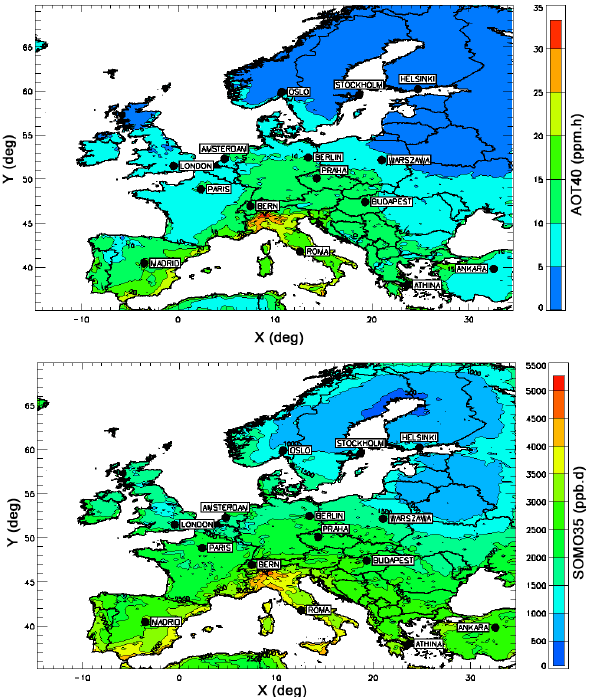
Figure 10. Modelled AOT40 (ppmh) (upper panel) and SOMO35 (ppbd) (lower panel) over the European domain for the reference year (2005).